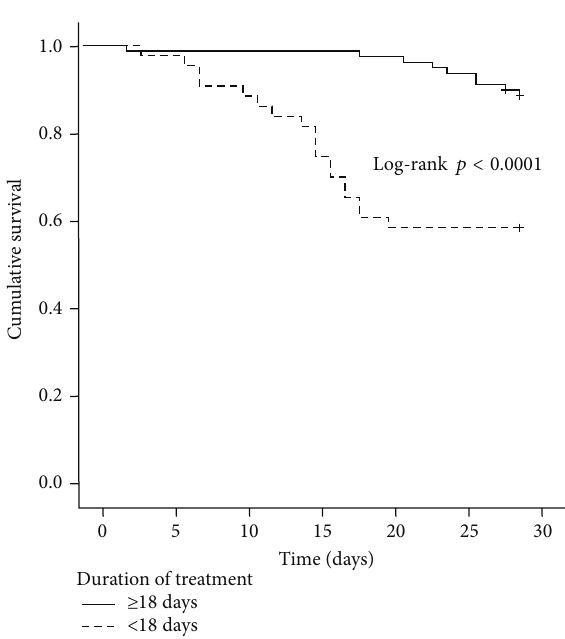
Figure 2: Kaplan-Meier survival analysis of the patient cohort: median overall survival was significantly longer in the responder group compared with nonresponders to terlipressin therapy: 29 months [95% CI 20.7–38.4] versus 8 months [95% CI 0.0–16.3] (treatment responders versus nonresponder group, log-rank test, 𝑝 = 0.007 ).